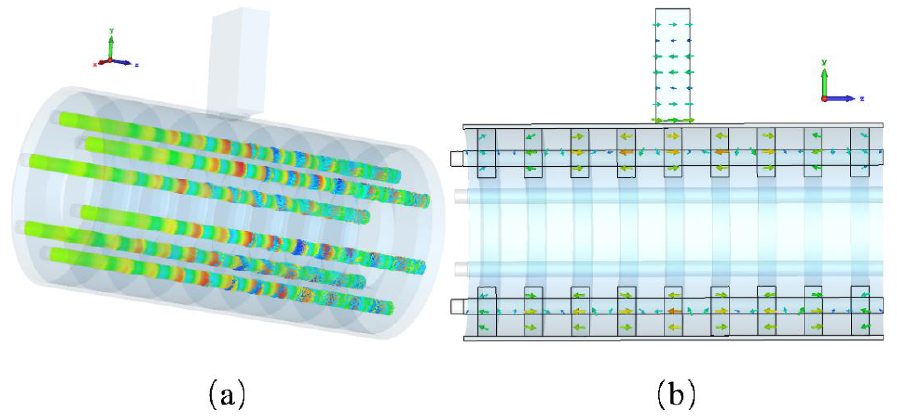
Figure 6. ( a ) A snapshot of 3D trajectory of the electrons in the six beam tunnels and ( b ) the EIO’s electric field distribution at the Y-Z plane after oscillation.